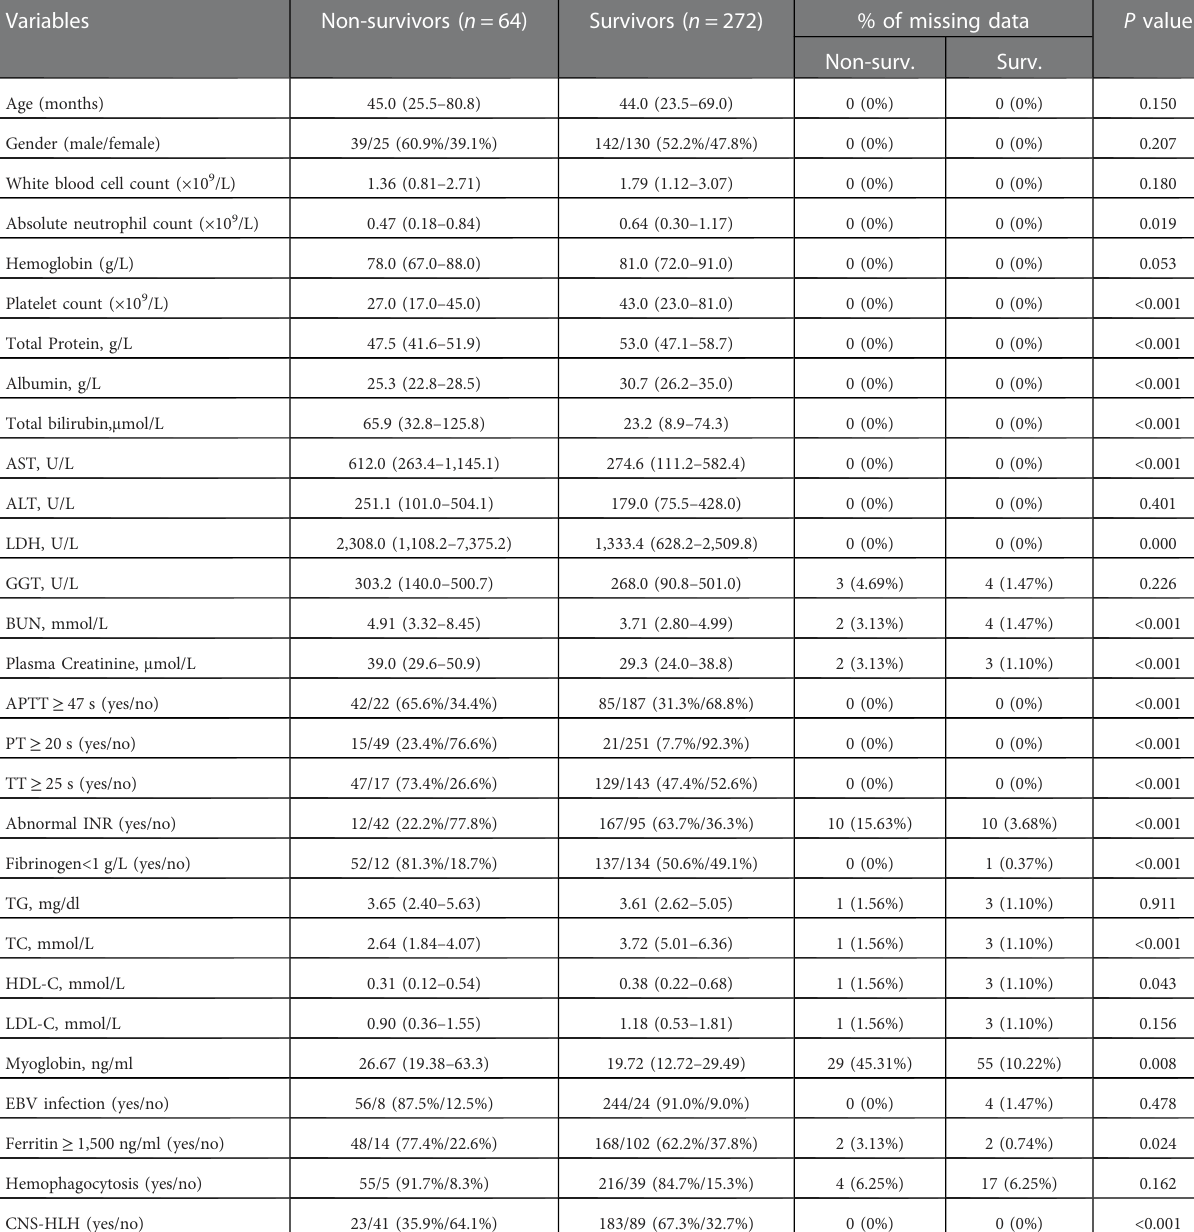
TABLE 2 Comparison of HLH subgroups in 336 HLH patients (30-days survival and non-survival).